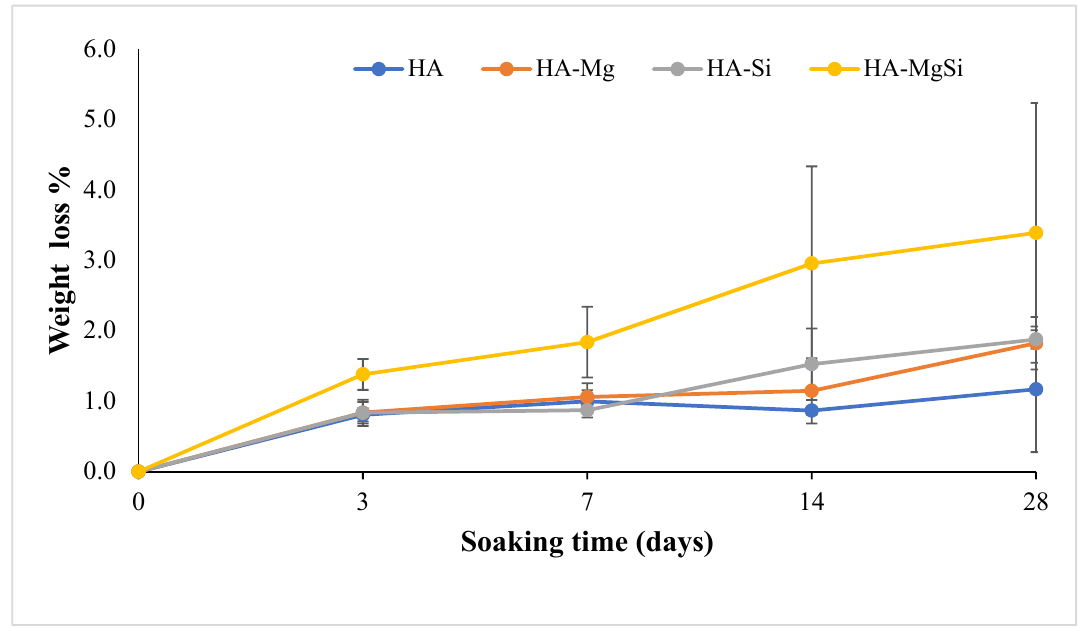
Figure 5. Stress–strain curve of all scaffolds synthesized (inset: sample after compression test).